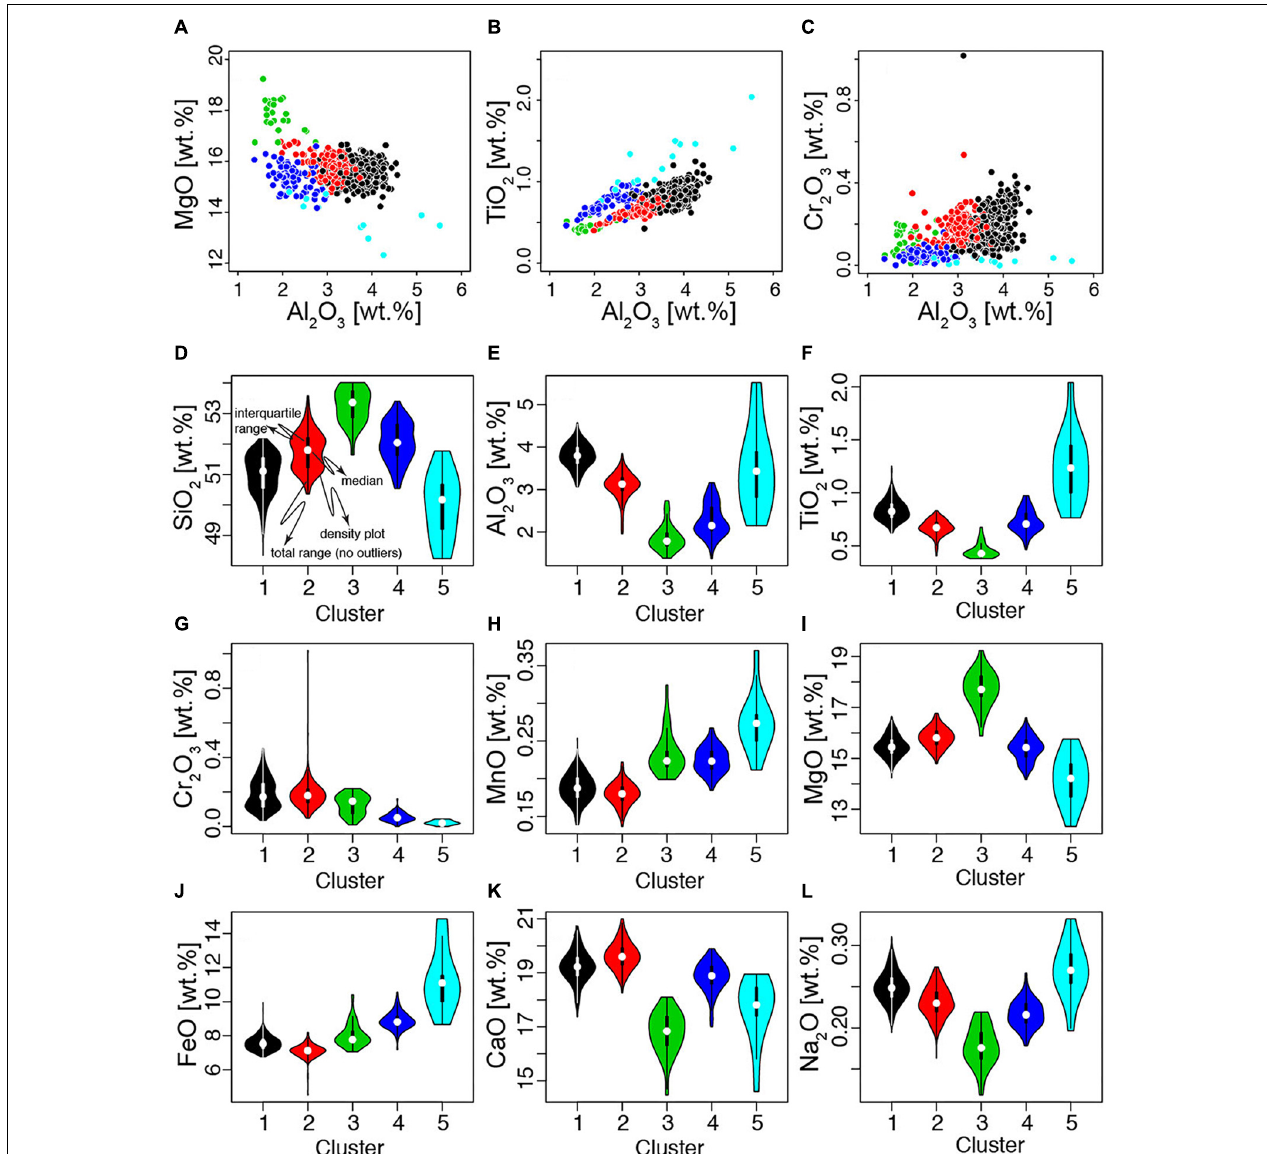
FIGURE 5 | (A–C) Harker diagrams of all analyses with color coding corresponding to the cluster assigned by HC. (D–L) Violin plots showing the density distribution of each oxide of each cluster of cpx chemistry. The violin plot show the density, and other descriptive characteristics of the distribution of each element for each of the compositional